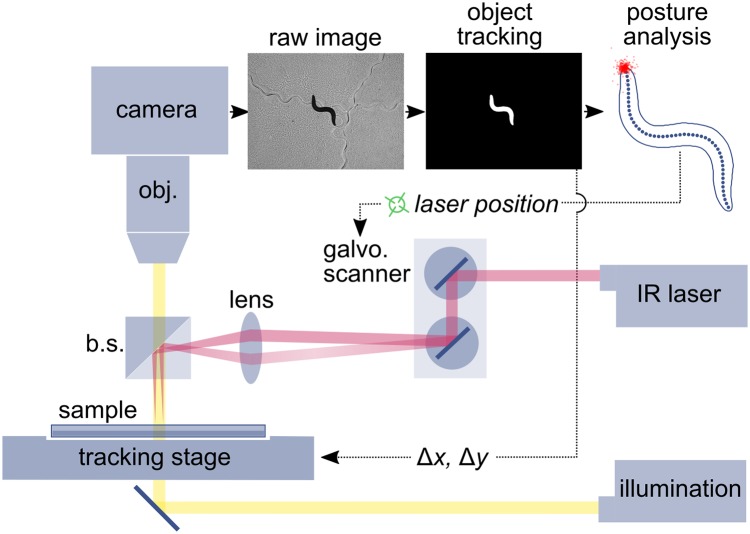
High spatiotemporal resolution thermal stimulation of freely behaving C. elegans.Worms crawl on an agar assay plate. The stage is manually moved by joystick to position a worm in the camera’s field of view, then the machine vision tracking system takes over automatic object tracking and laser targeting for the duration of the experiment. Dotted lines indicate flow of information in the system. The two red lines from ‘IR laser’ indicate two possible paths of the thermal stimulation beam, which is focused to a spot at the target position on the worm’s body. The red dots plotted around the head of the skeletonized worm indicate the laser locations for 392 stimuli. The worm’s body is approximately 1 mm long. See S1A Fig for a histogram of the head-stimulus distances. The yellow line from ‘illumination’ indicates the bright field illumination used to visualize the worm. Abbreviations: obj. = objective lens; b.s. = polarizing beam splitter; lens = 75 mm or 100 mm laser focusing lens; galvo. scanner = pair of galvanometer-driven scanning mirrors. See Methods for further details.